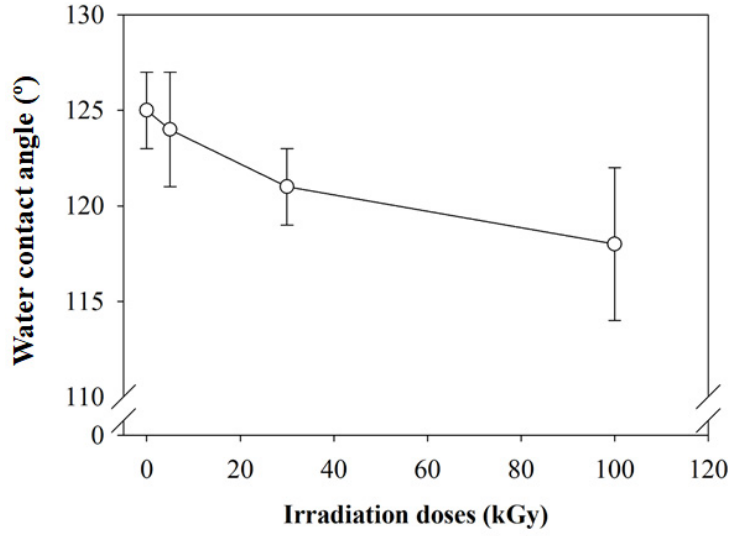
Figure 3. Changes in WCA with increase of irradiation doses.